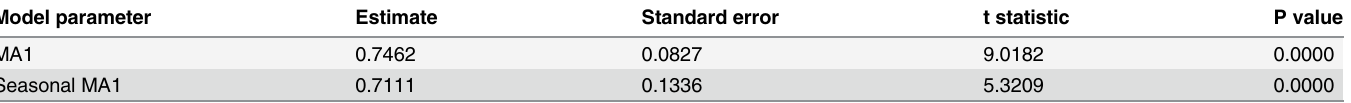
Table 2. Parameter estimates and their testing resulting of the final seasonal ARIMA (0,1,1)×(0,1,1) 12 model. Model